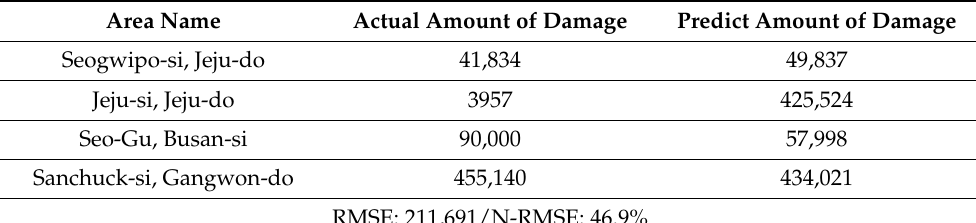
Table 5. Simulation result of Model (unit: KRW1000). Area